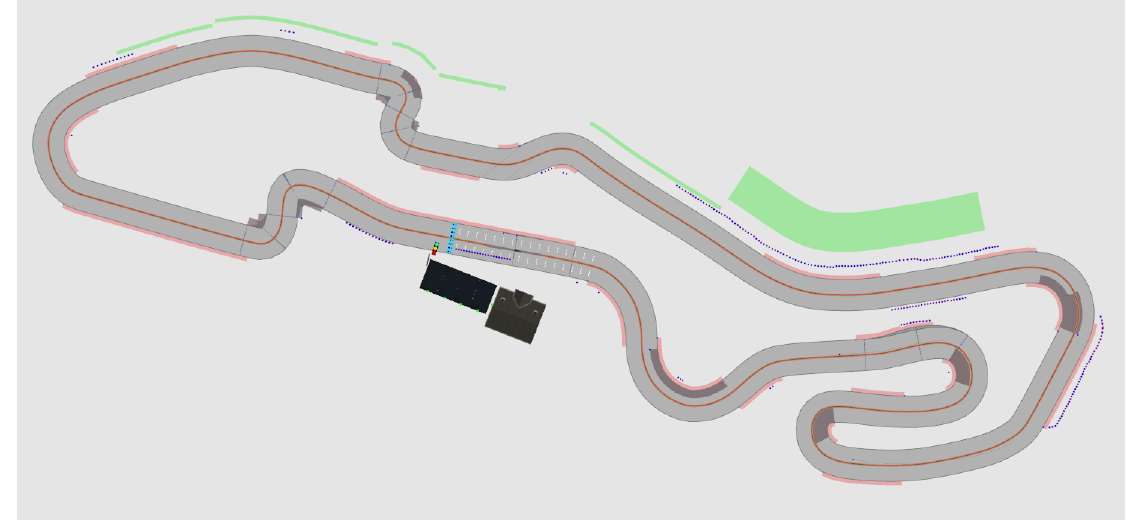
Figure 8. Olaberria circuit aerial view.